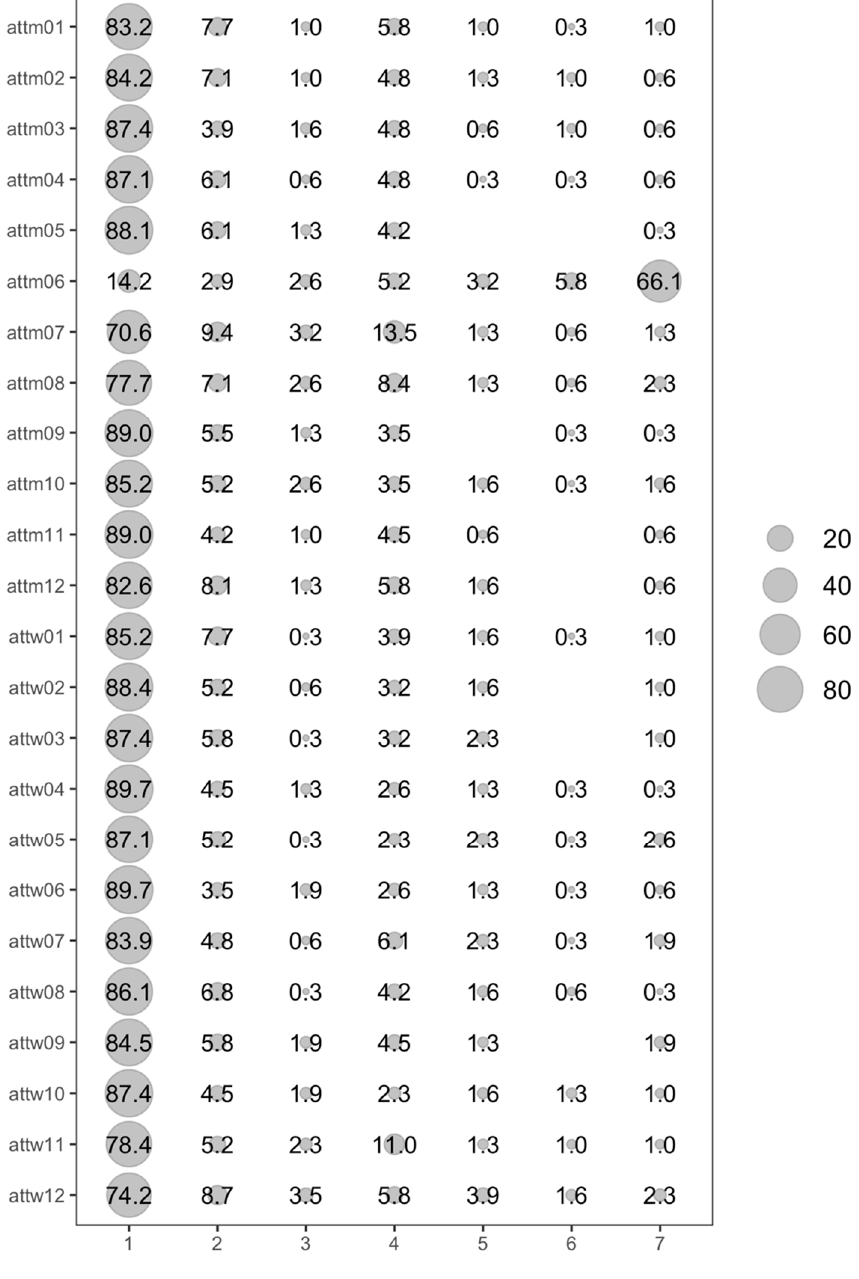
Figure 1. Item Distribution for ATTMW.